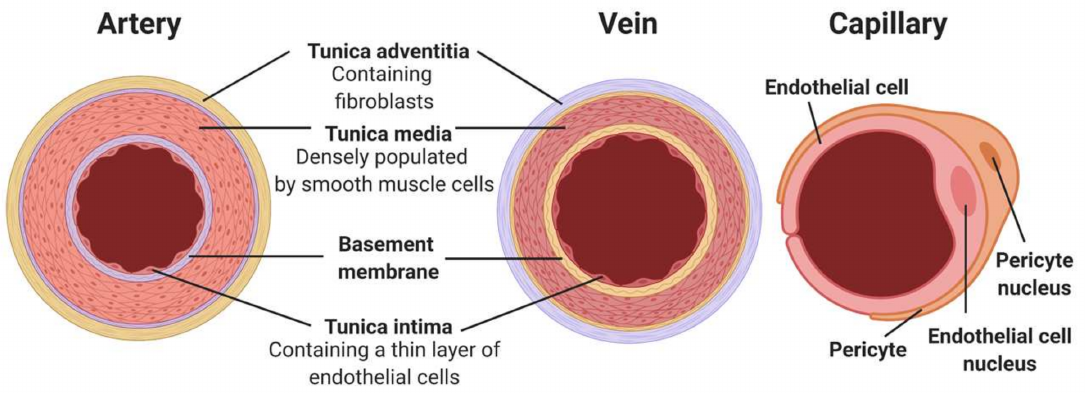
Figure 1. Structure of blood vessels. Diagram shows compositions of the three main types. From left to right: artery, vein and capillary. (Created with BioRender.com, accessed on 8 January